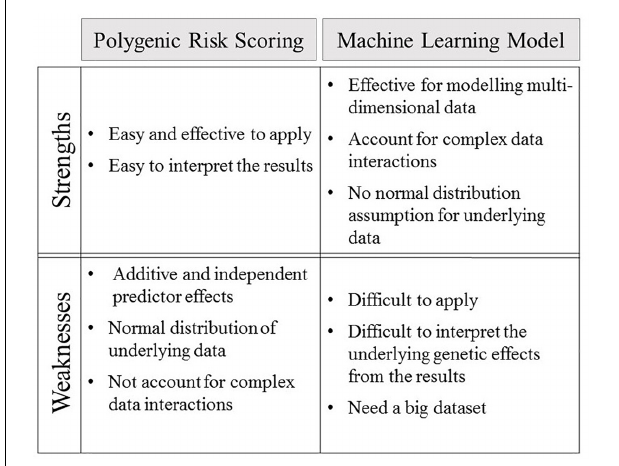
FIGURE 2 | The strengths and weaknesses of polygenic risk scoring and machine learning